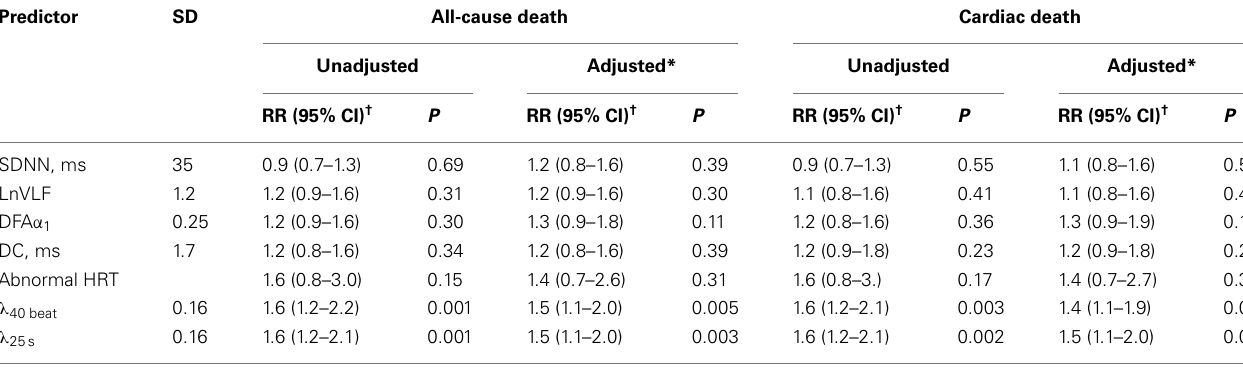
TableA1 |Associations of HRV indices with mortality risk in CHF patients. Predictor SD All-cause death Cardiac death Unadjusted Adjusted*